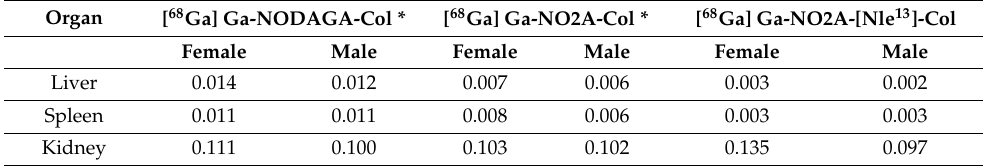
Table 1. Estimated absorbed doses (mGy/MBq) of [ 68 Ga] Ga-NODAGA-Col, [ 68 Ga] Ga-NO2A- Col and [ 68 Ga] Ga-NO2A-[Nle 13 ]-Col in human females and males extrapolated from rat organ distribution